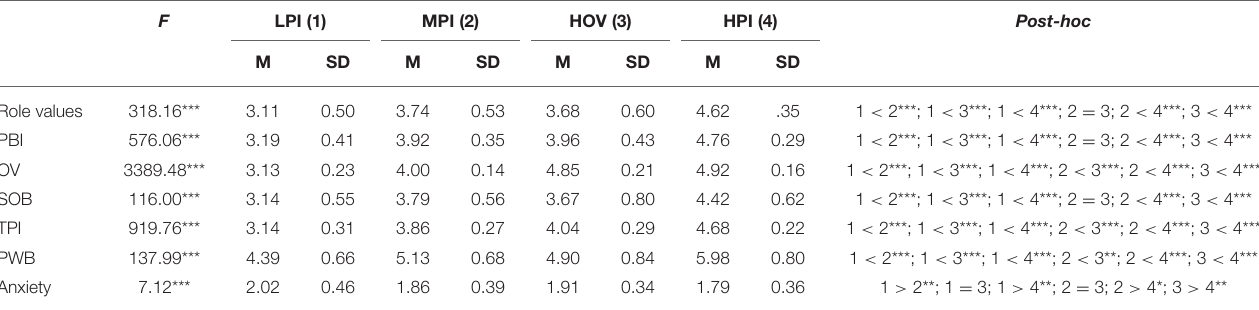
TABLE 4 | Differences in means of teacher professional identity, psychological wellbeing and anxiety across latent profiles.